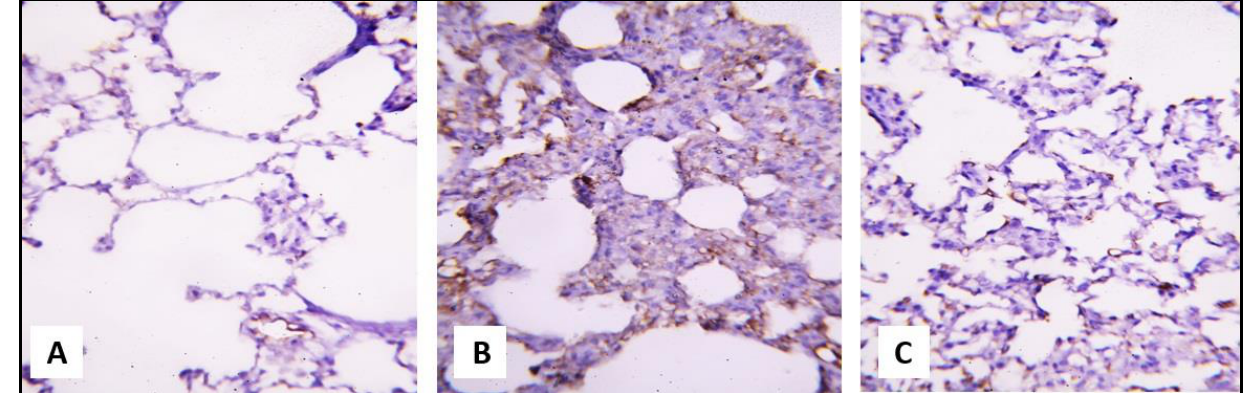
Figure 7. A section of a rat lung showing the following features. ( A ) A weakly positive brown cytoplasm reaction in the alveolar epithelial lining of the control (iNOS immunostaining, ×400). ( B ) A dense, positively brown cytoplasm reaction in the alveolar epithelial lining, inflammatory interstitial cells, and endothelial cells of group II (iNOS immunostaining, ×400). ( C ) A weakly positive brown cytoplasm reaction in the alveolar epithelial lining and endothelial cells of group III (iNOS immunostaining, ×400).